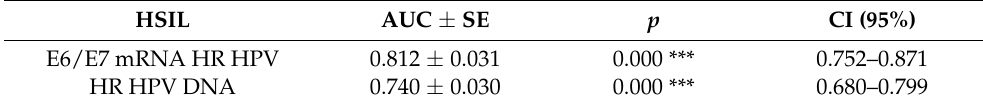
Table 11. Performance of E6/E7 mRNA HR HPV and HR HPV DNA tests in HSIL.